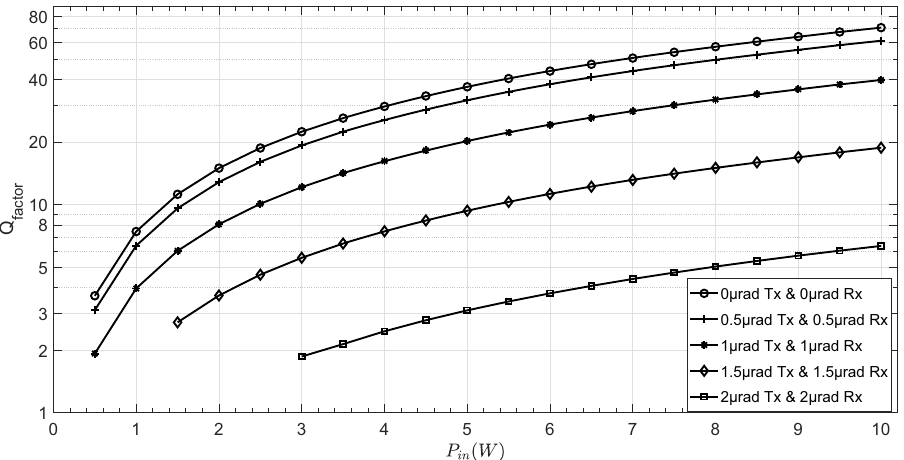
Figure 12: Quality factor ( Q factor ) as a function of the transmitted laser power ( P W in ( ) ) for di ff erent transmitter and receiver pointing errors.